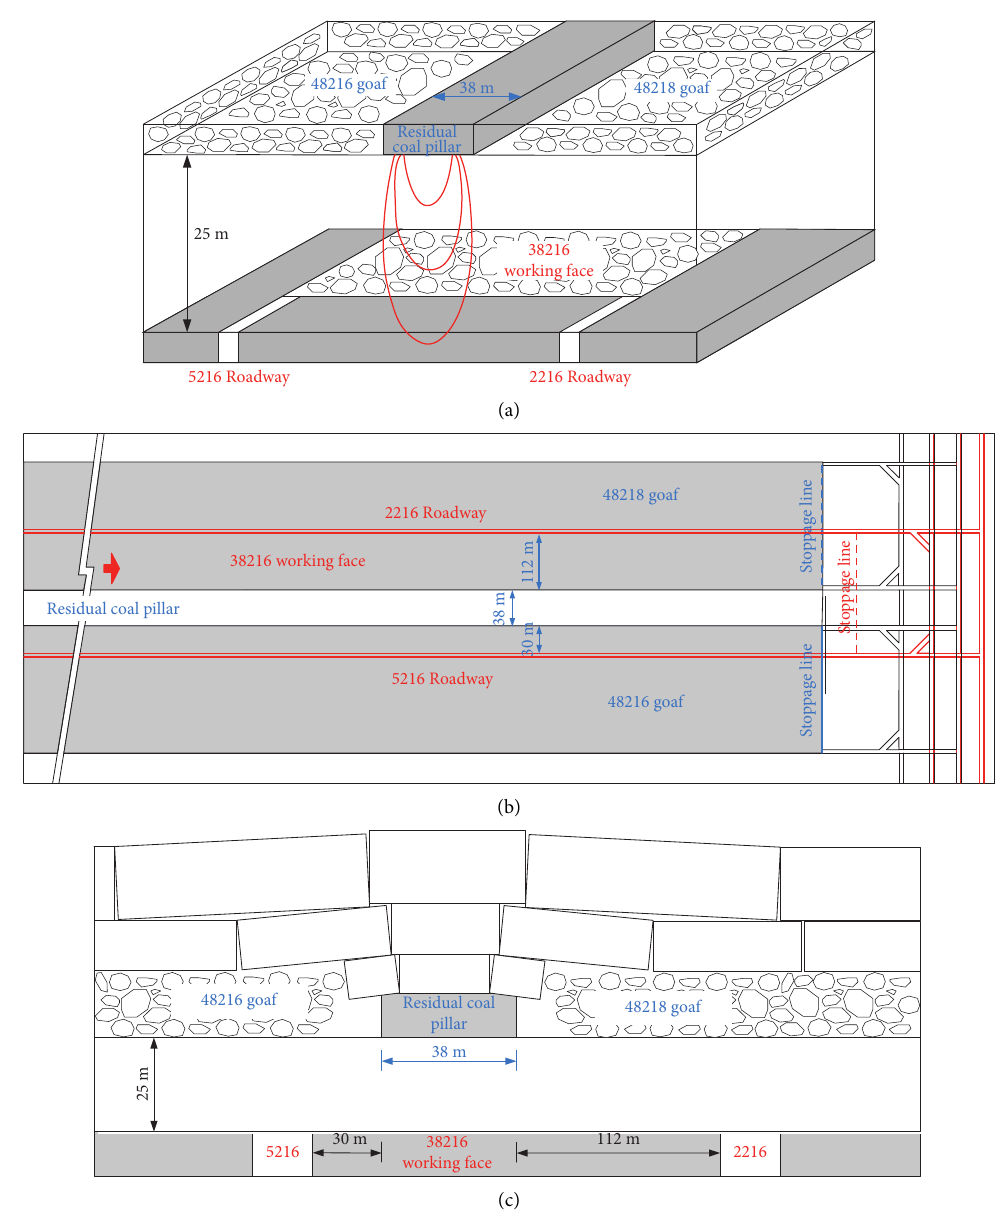
Figure 1: Spatial positional relationships between working faces. (a) Space location diagram. (b) Plane figure. (c) Section